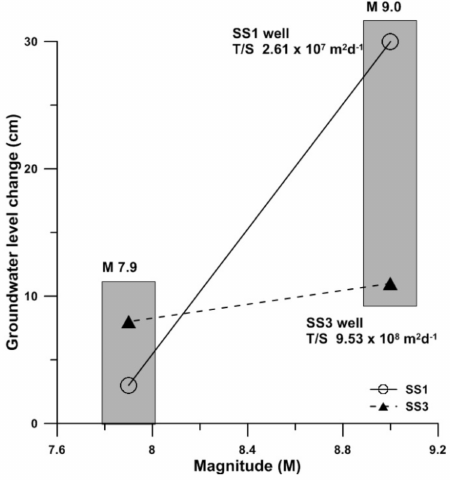
Figure 5. Groundwater level changes at wells SS-1 and SS-3 caused by the M 7.9 and M 9.0